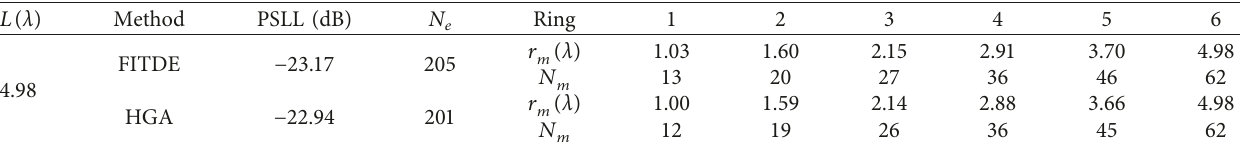
Figure 7: Result of Example 1. (a) PSLL of 50 independent runs. The best PSLL is − 23.17dB, the average PSLL is − 22.76dB, and the variance is 0.095. (b) is the best radiation pattern of all planes, characteristic of excellent symmetry. (c) is the sectional pattern of one single plane. (d) is the optimal distribution of elements. Table 5: Results of Example